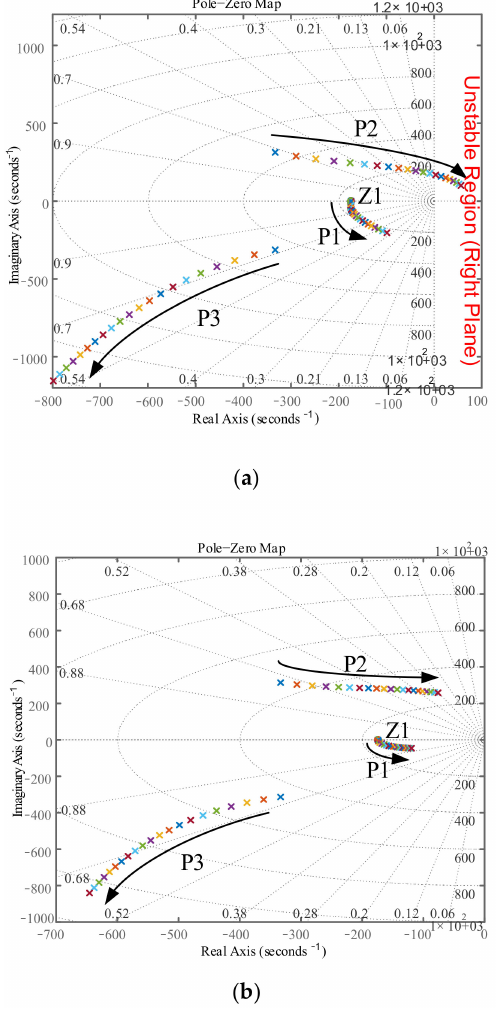
Figure 17. Zero pole distribution diagram before and after delay compensation:( a ) Before compensa- tion; ( b ) After compensation.